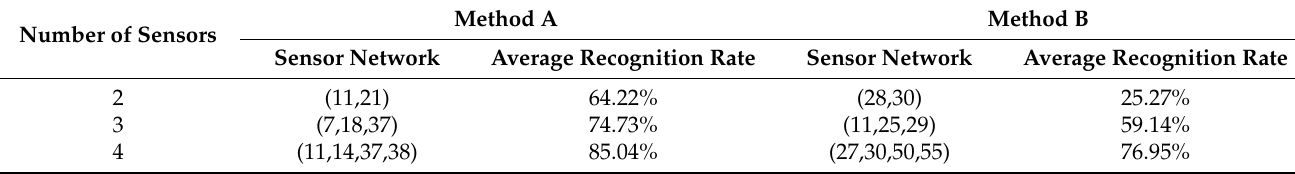
Table 8. Impact recognition rate of different